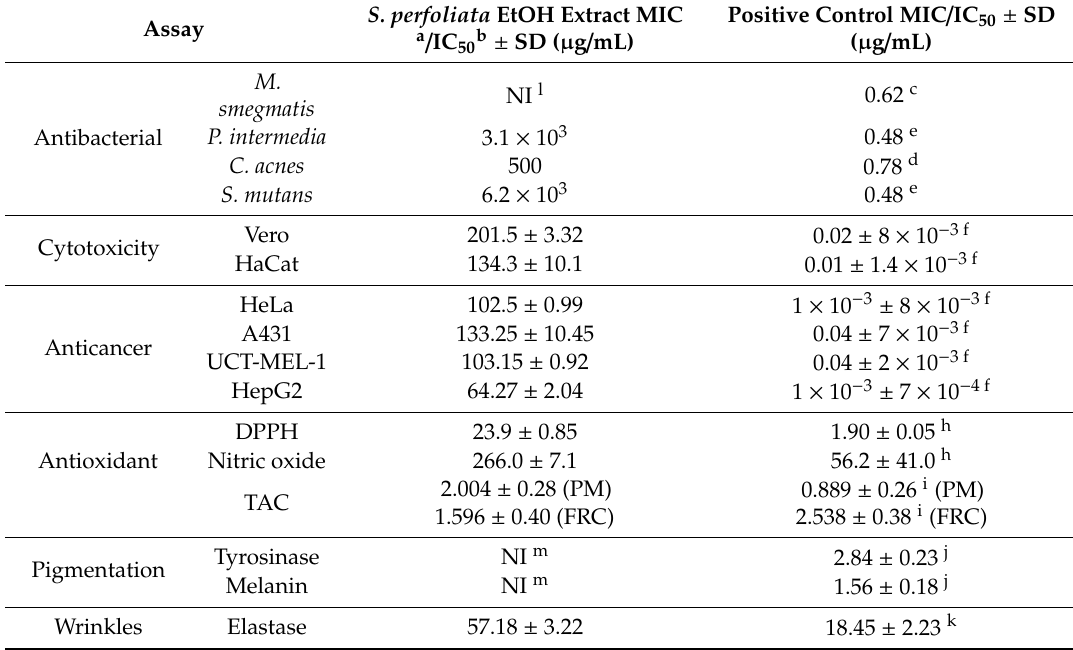
Table 2. Biological activity of Sideritis perfoliata ethanolic extract. Data presented is the average of three replicates ± standard deviation